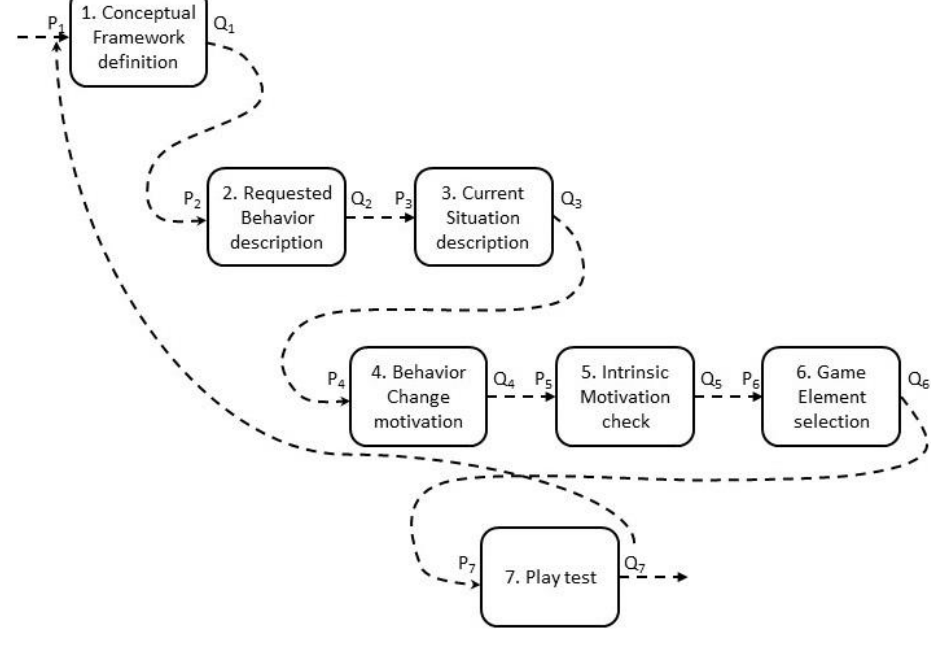
Figure 2. Framework from [13] showing the steps of the framework with preconditions (P